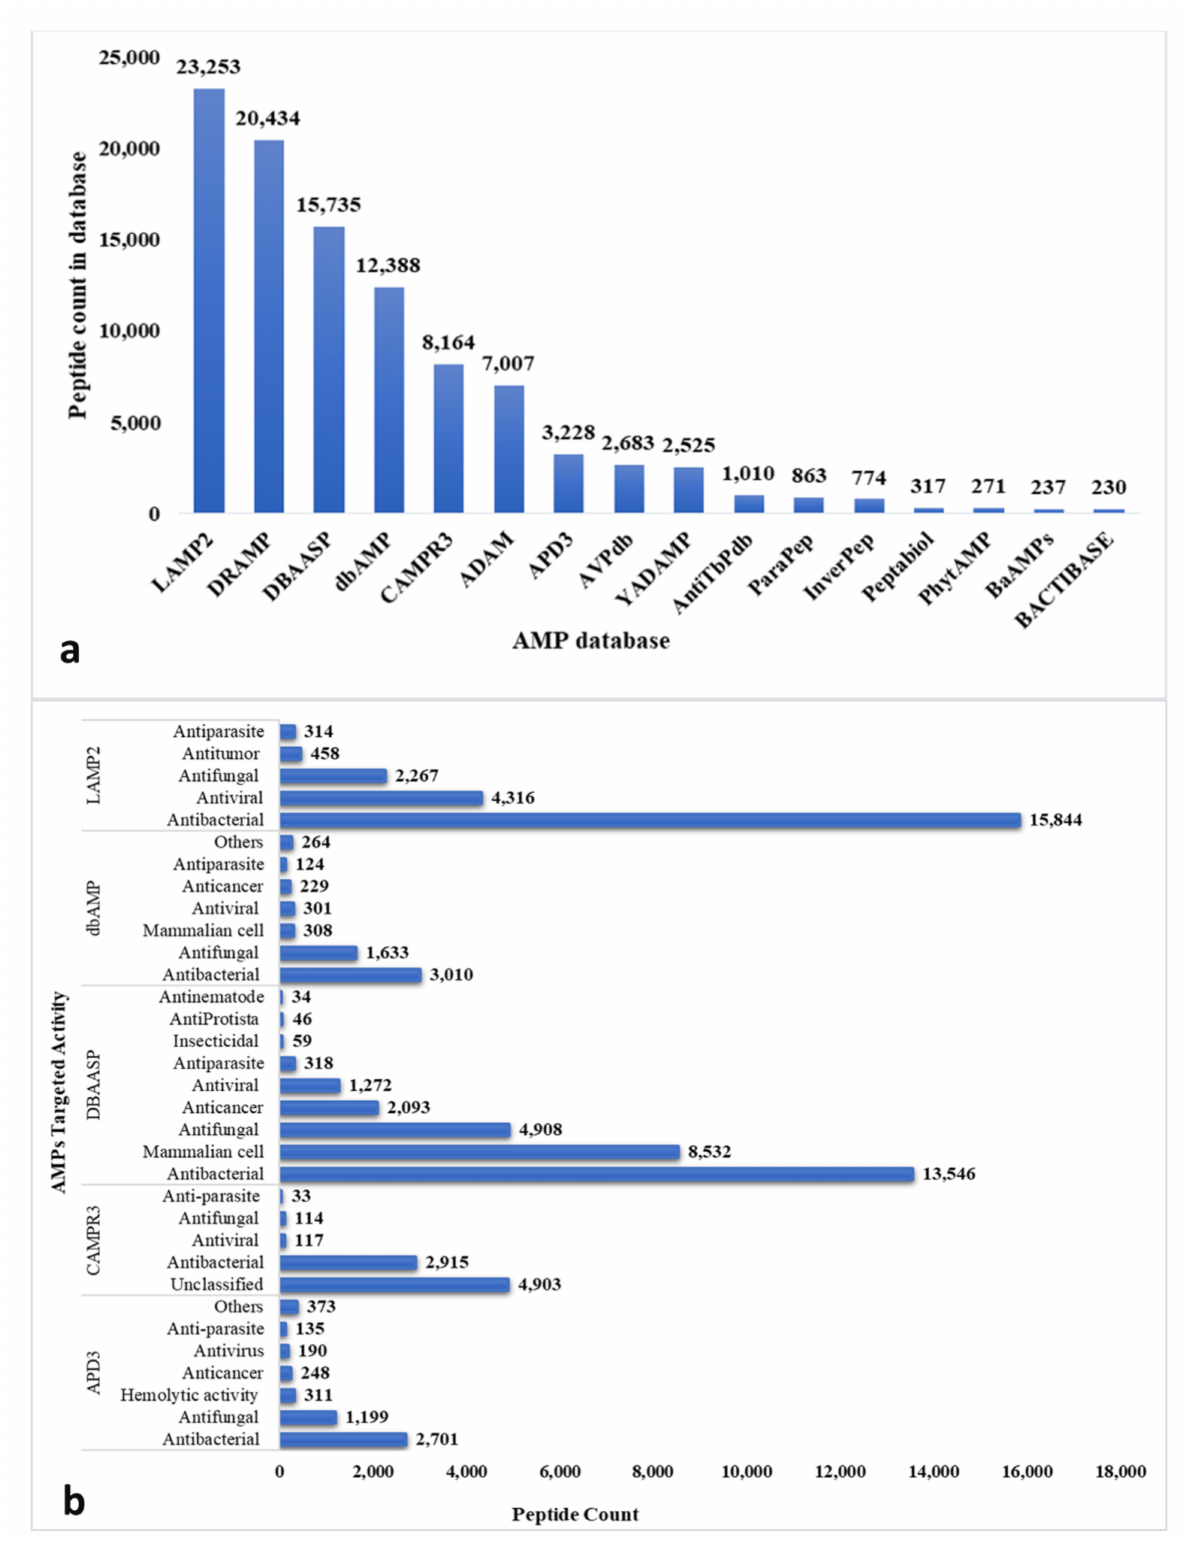
Figure 5. ( a ) The total number of AMPs contained in a variety of databases and ( b ) breakdown of AMPs by targeted activity in five representative